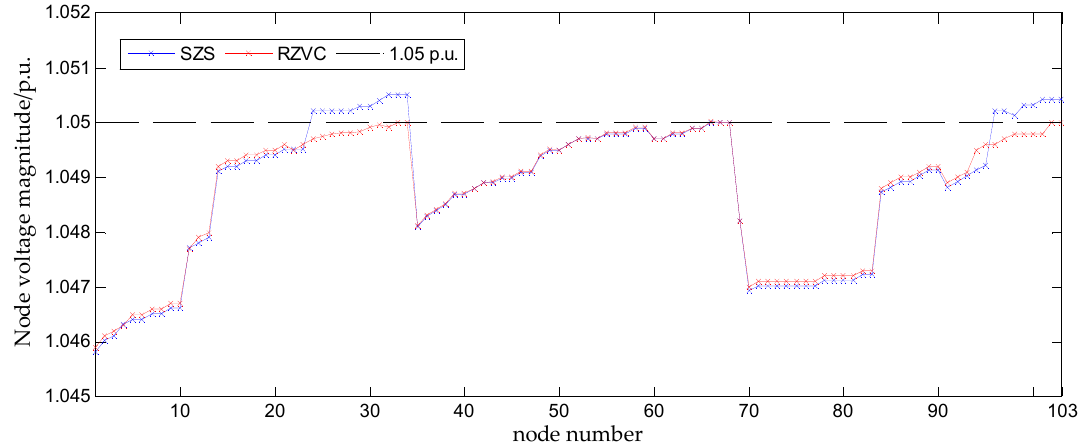
Figure 11. Active power curtailed by the PV inverters under SZS and RZVC.